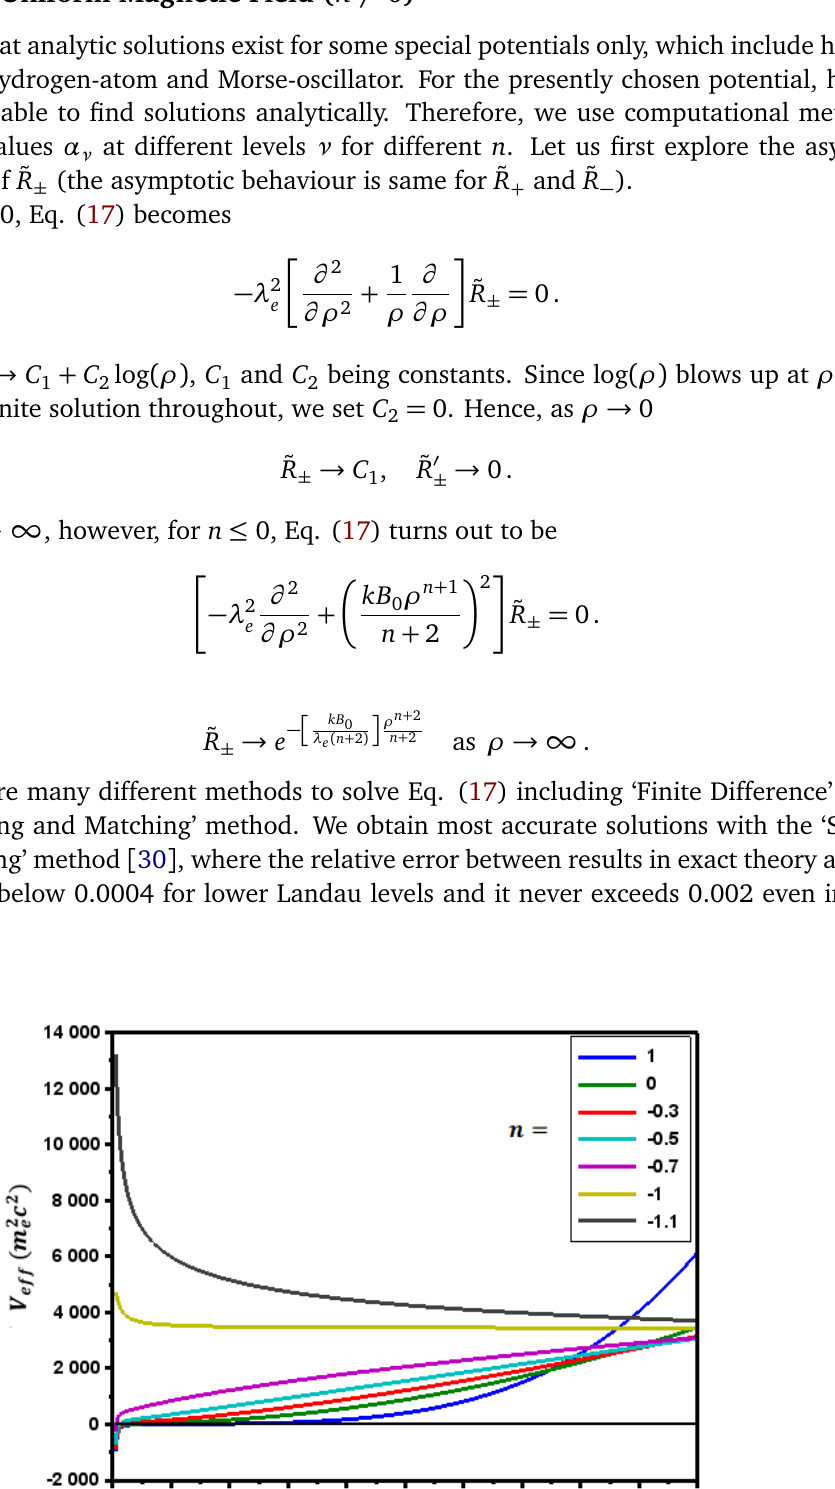
Figure 1: The variation of effective potential for different n for B Here, the black horizontal line represents V from bottom to top successively are for n = 1,0, − 0.3, − 0.5, − 0.7, − 1, −